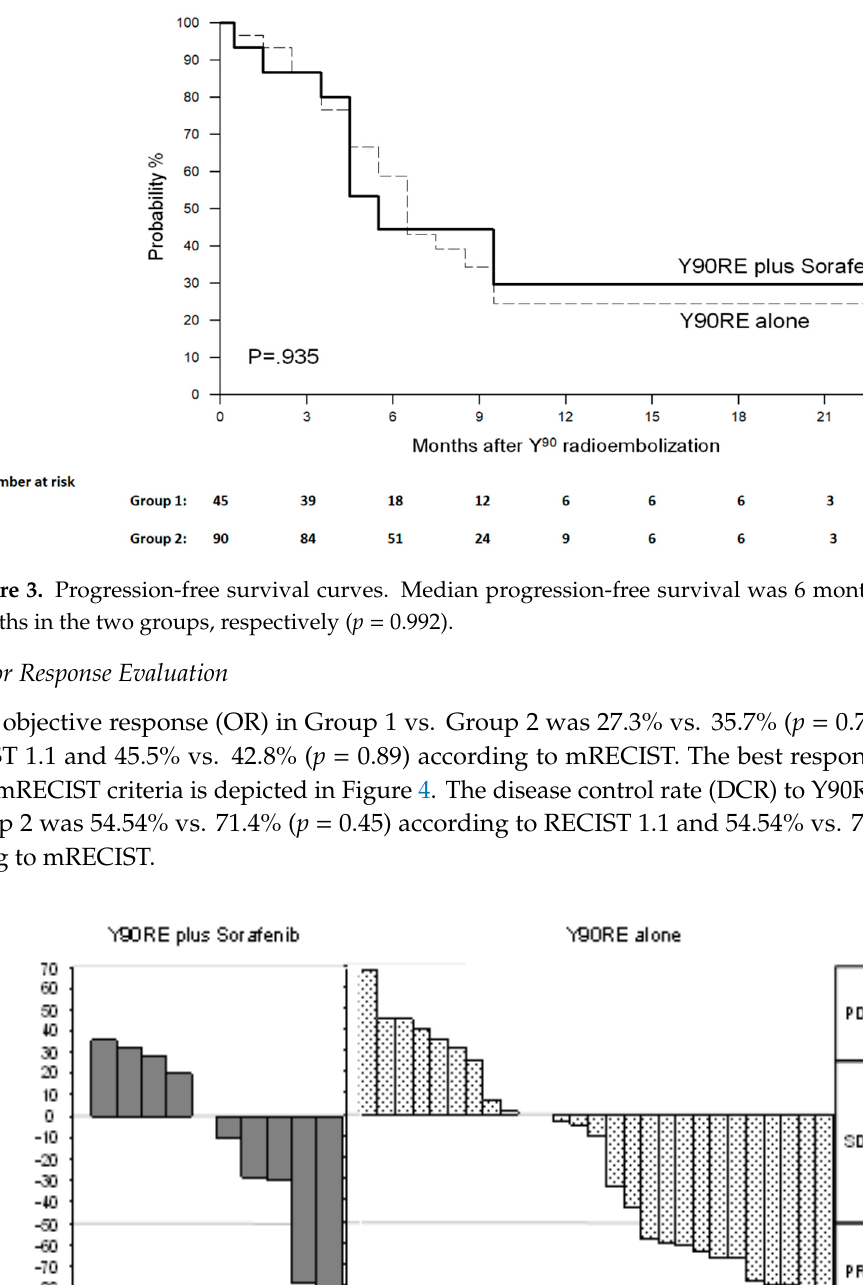
Figure 4. Waterfall graphic representing the tumor response rate in the two groups. CR, complete response; PD, progressive disease; PR, partial response; SD, stable disease.